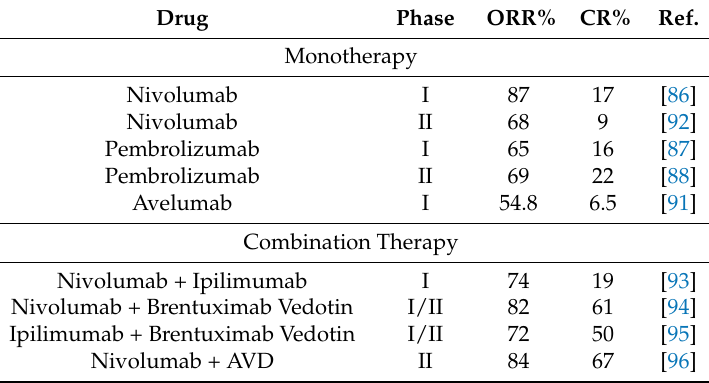
Table 1. Summary of clinical trial data for anti-PD-1 (program death 1) monotherapy, combination Hodgkin